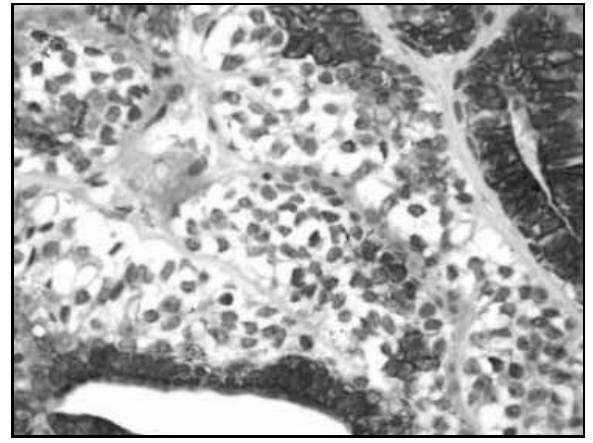
Figure 3 – Positive reaction to the AE1/AE3 marker in epithelial cells (IHQ 400×) IHQ: immunohistochemical.